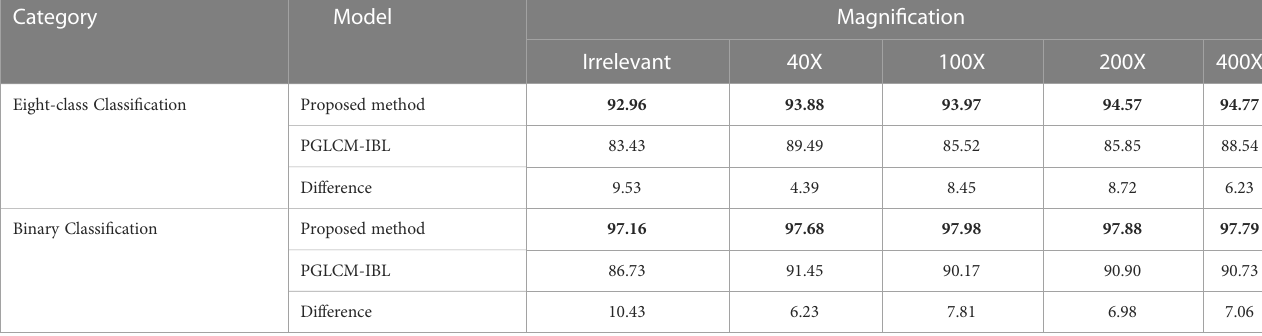
TABLE 9 Comparison of accuracy (%) of PGLCM-SARF and PGLCM-IBL.